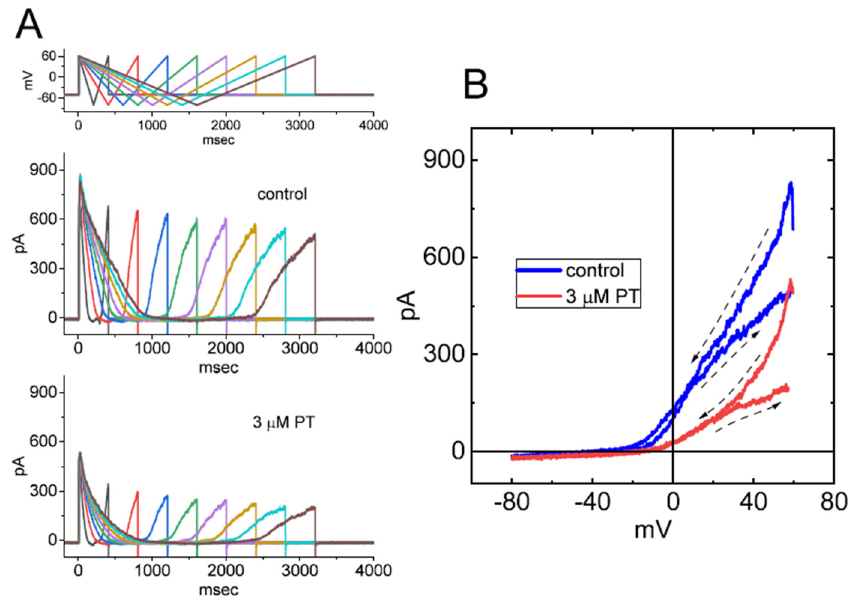
Figure 8. Effect of PT-2385 on hysteresis of I K(DR) activated by inverted ITRV in GH 3 cells. ( A ) Representative current traces obtained in the absence (upper image) and presence of 3 µ M PT-2385 (lower image). Current traces were activated by inverted ITRV at varying durations (indicated in the uppermost part). ( B ) Representative hysteresis of I K(DR) elicited by inverted ITRV with a ramp speed of ± 87.5 mV/s. Dashed arrows in ( B ) indicate the direction of I K(DR) over which time goes during the elicitation by ITRV. Of note, the hysteretic behavior of I K(DR) in response to inverted ITRV was still observed and was greater than that by upright ITRV, while cell exposure to 3 µ M PT-2385 decreased the ∆ area of voltage-dependent hysteresis evoked by inverted ITRV.